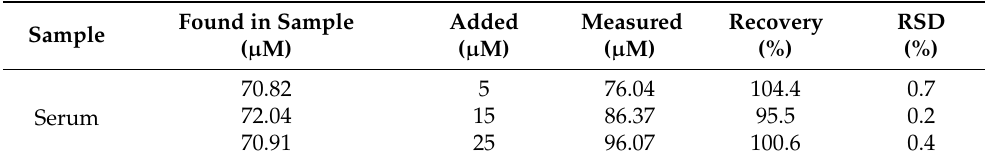
Table 3. Determination of Arg in bovine serum.